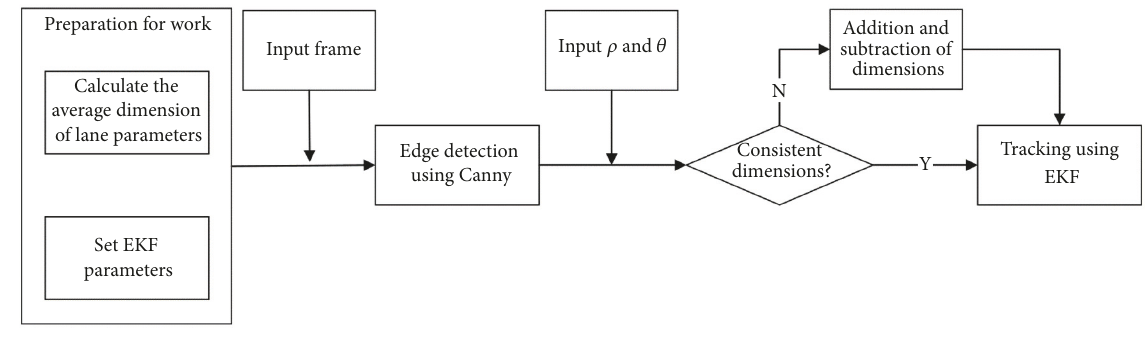
Figure 4: EKF Algorithm. Table 1: Extended Kalman Filter algorithm